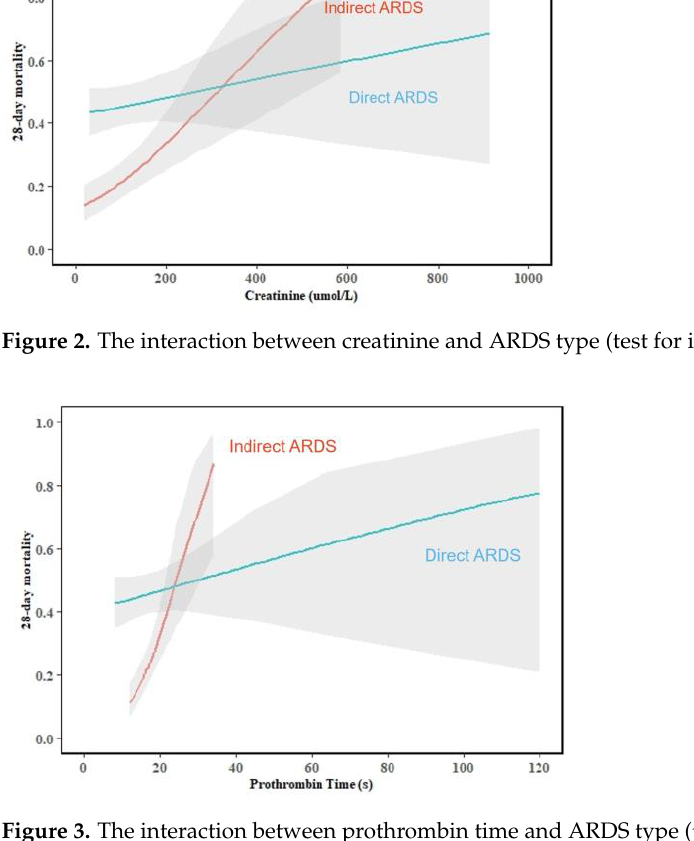
Figure 4. The interaction between oxygenation index and ARDS type (test for interaction, p < 0.001). 4. Discussion